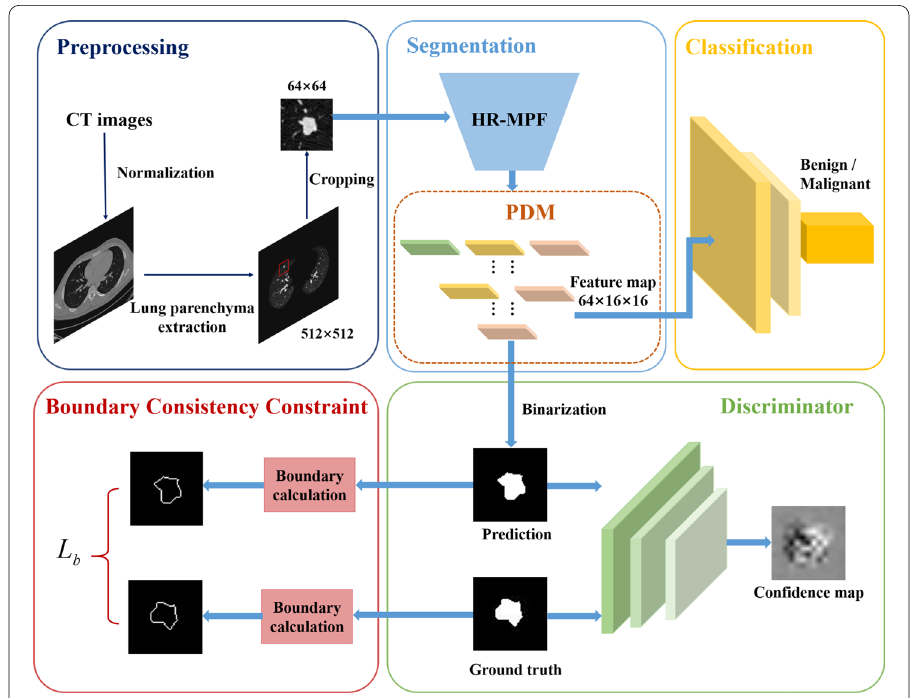
Fig. 1 The architecture of our proposed framework for pulmonary nodule segmentation and classification. HR-MPF is a feature extraction network, and PDM generates segmented pulmonary nodules. Classification module differentiates benign and malignant pulmonary nodules. The discriminator jointly optimizes segmentation and classification of pulmonary nodules in which a loss function with boundary consistency constraint is proposed to calculate inconsistency between the boundaries of prediction and ground